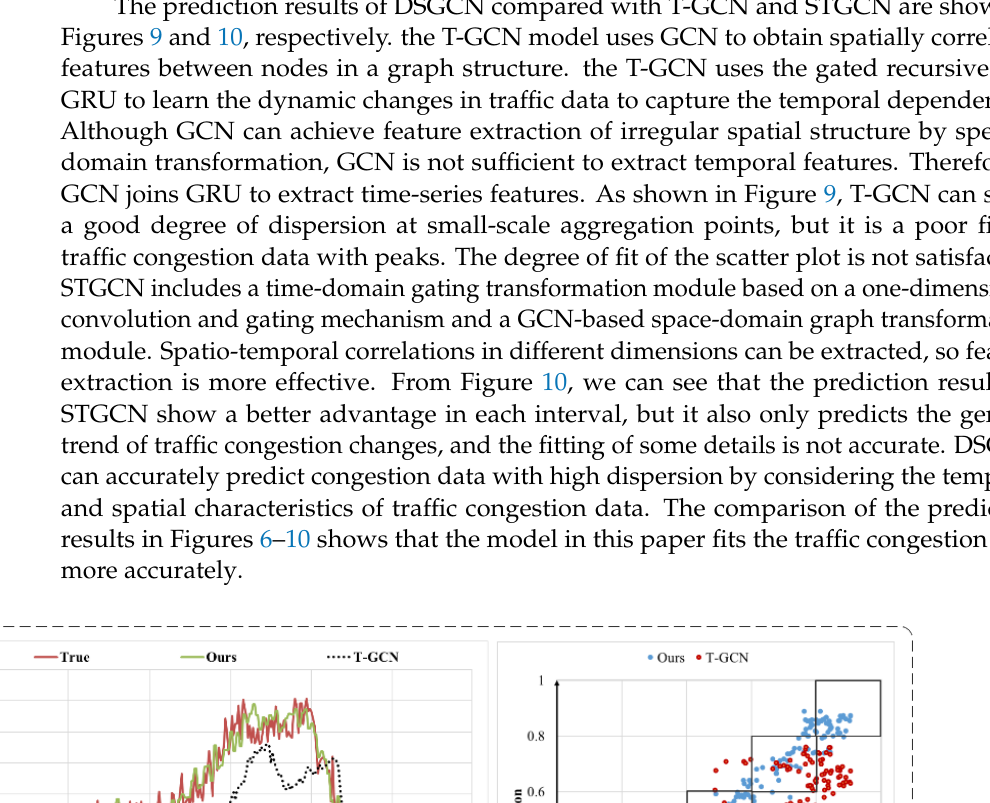
Figure 8. Comparative effect of DSGCN and ConvLSTM predictions. ( a ) is a time-series variation plot. ( b ) is a numerical scatter plot.